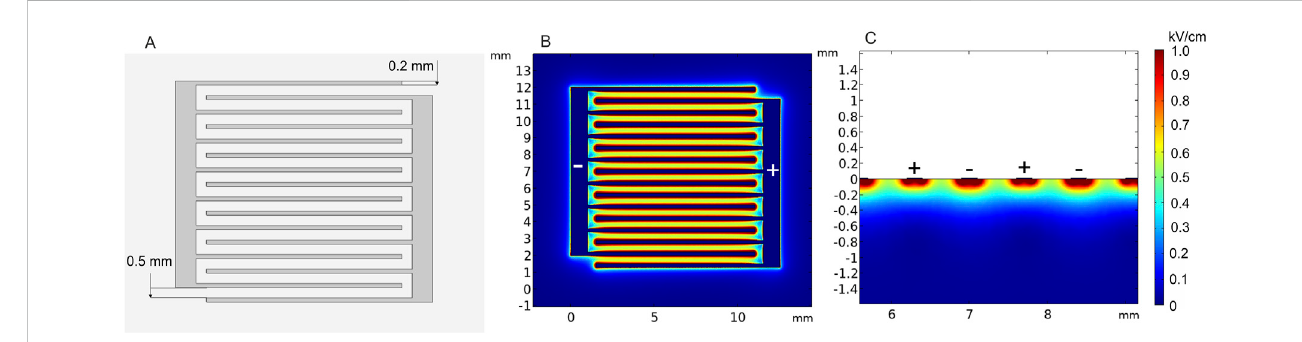
FIGURE 12 Micromachined pliable electroporation patch (ep-Patch) with rectanglular parallel gold electrodes, using 50 V terminal voltage. (A) Electrode structure; (B) spatial electric fi eld distribution, top view; (C) spatial electric fi eld distribution, side view.